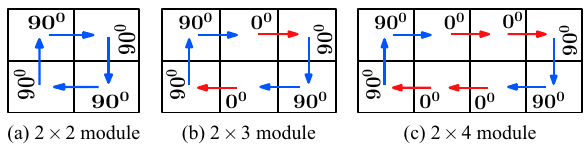
Fig. 6 Different types of modules present in 1 × N mixing structure